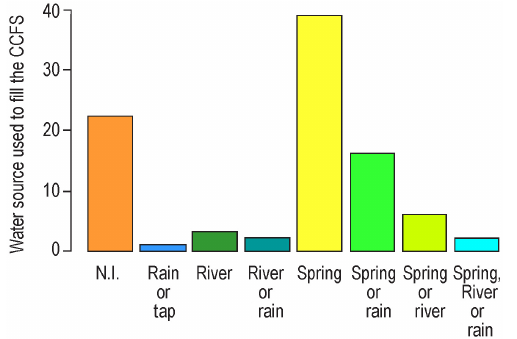
Figure 5. Water sources used for the filling of the CCFSs in 91 households.